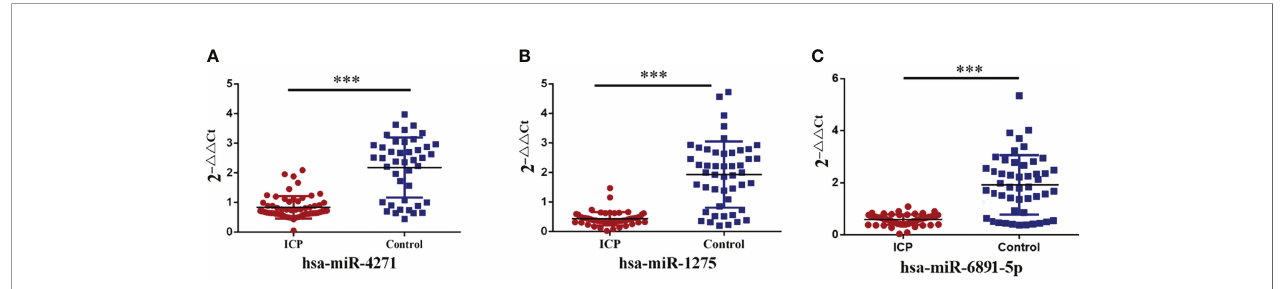
FIGURE 4 | Validation of alteration in serum exosome miRNA levels. (A) Serum exosome levels of hsa-miR-4271 in ICP and control groups (P = 0.000). (B) Serum exosome levels of hsa-miR-1275 in ICP and control groups (P = 0.000). (C) Serum exosome levels of hsa-miR-6891-5p in ICP and control groups (P = 0.000);